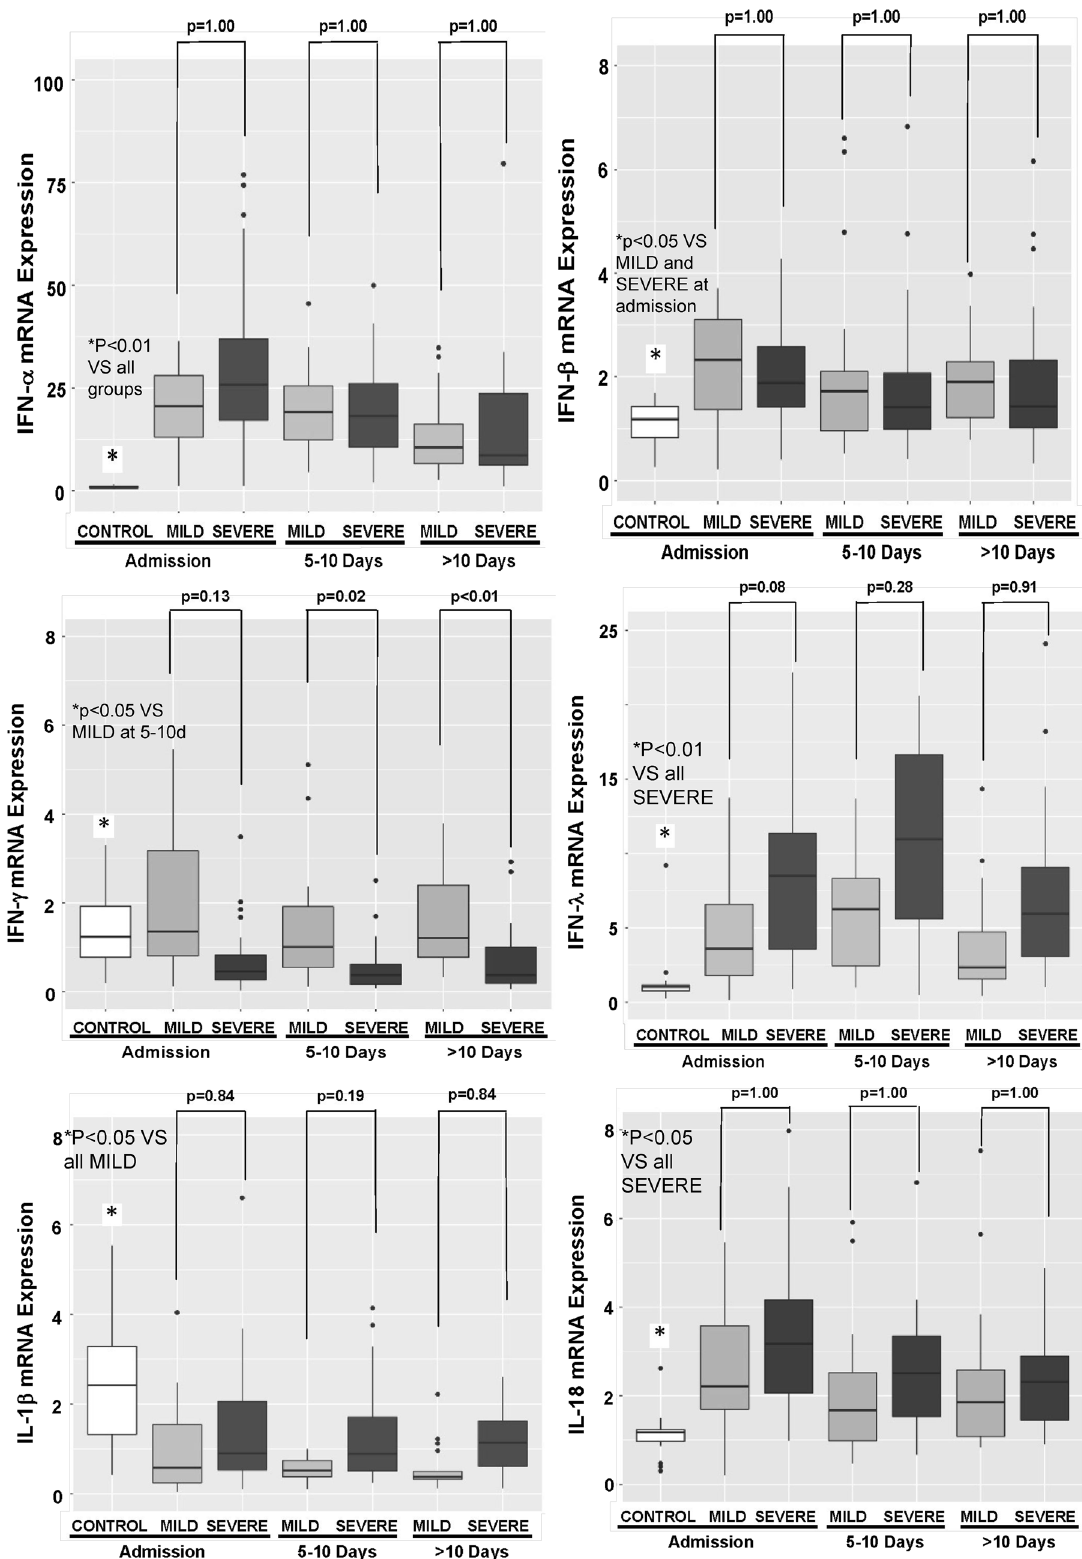
Figure 5. Quantitative mRNA of cytokines in circulating leukocytes of patients with COVID-19 during hospital stay. Expression of cytokines (mRNA) was measured in circulating leukocytes. Blood samples were collected every five days as feasible during hospitalization. IFN-γ mRNA expression was lower in COVID-19 SEVERE (N = 24 patients) in comparison to COVID-19 MILD (N = 17 patients), and widened during the hospital internment. Controls are also shown (17 patients). P values were calculated using the nonparametric Kruskal–Wallis test in R software (version 4.0.3 for